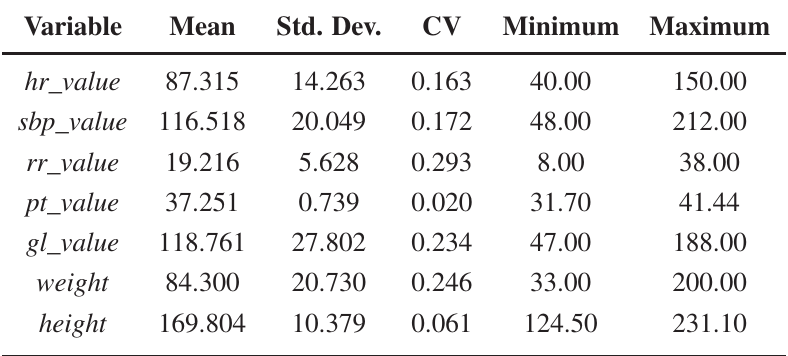
Table 1. Summary Measures of the Population of